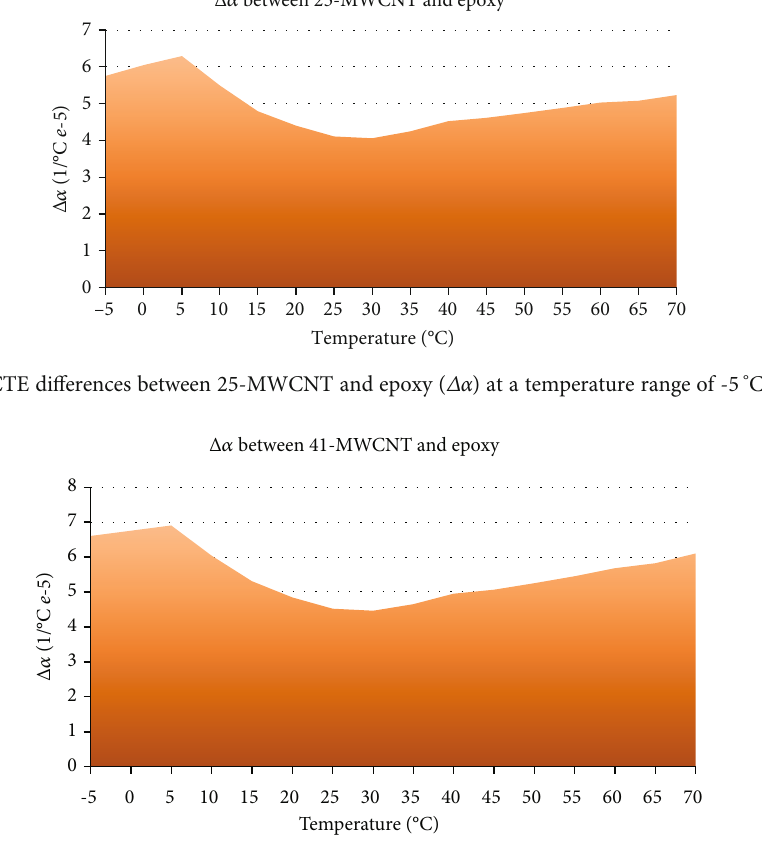
Figure 4: CTE di ff erences between 41-MWCNT and epoxy ( Δα ) at a temperature range of -5 ° C to 70 °